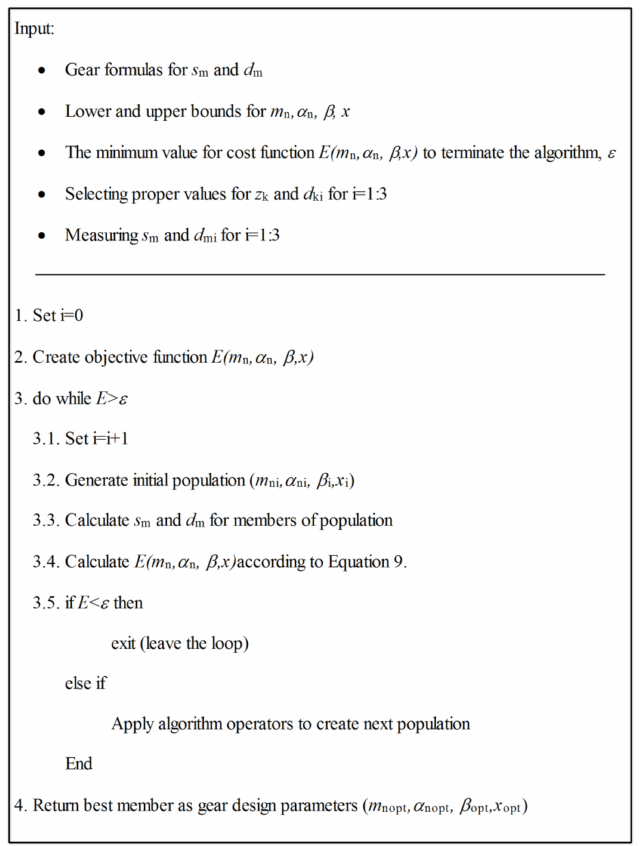
Figure 3. Pseudocode of the proposed algorithmic